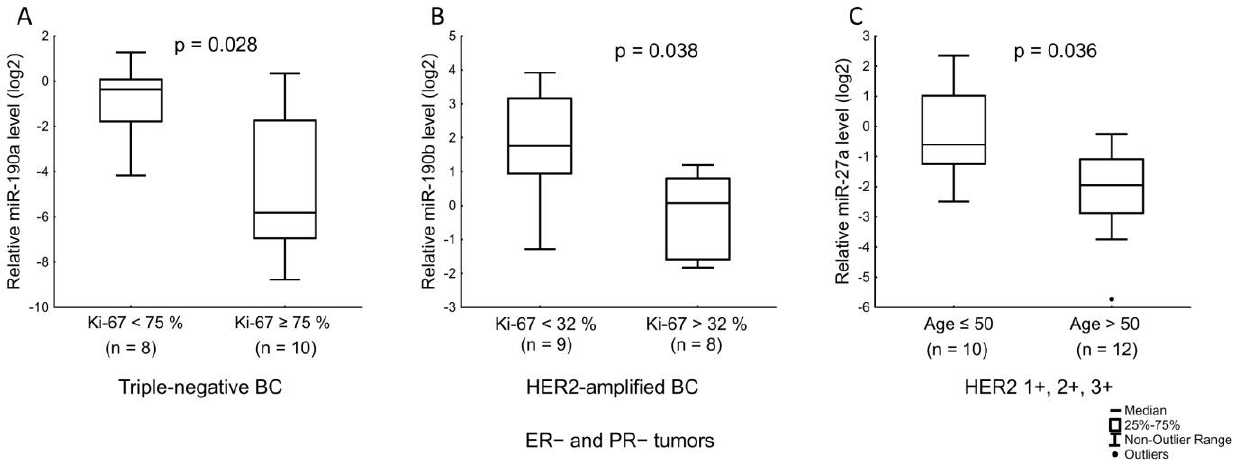
Figure 12. The comparison of miR-190a, miR-190b, and miR-27a expression between different cancerous tissue groups: ( A ) relation of miR-190a level with Ki-67 index in TNBC (75% was the median value of Ki-67); ( B ) relation of miR-190b level with Ki-67 in HER2-amplified tumors (32% was the median value of Ki-67); ( C ) relation of miR-27a level with age of patients with HER2-expressing tumors. The Y axis presents the expression level ( log 2 2 –ΔΔCt ); the results were normalized to the control (normal tissue).